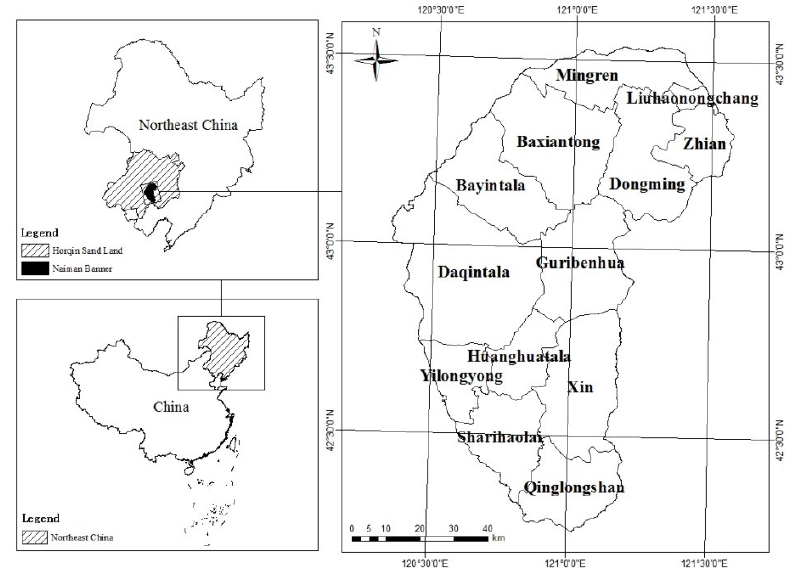
Figure 1. Location of the study area in Horqin Sand Land and Northeast